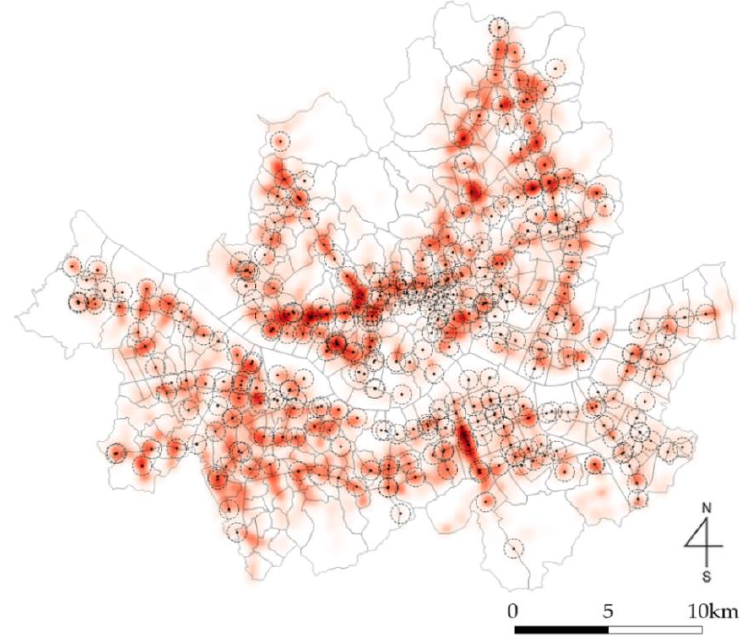
Figure 2. Heat-map of transfer trips on station area.